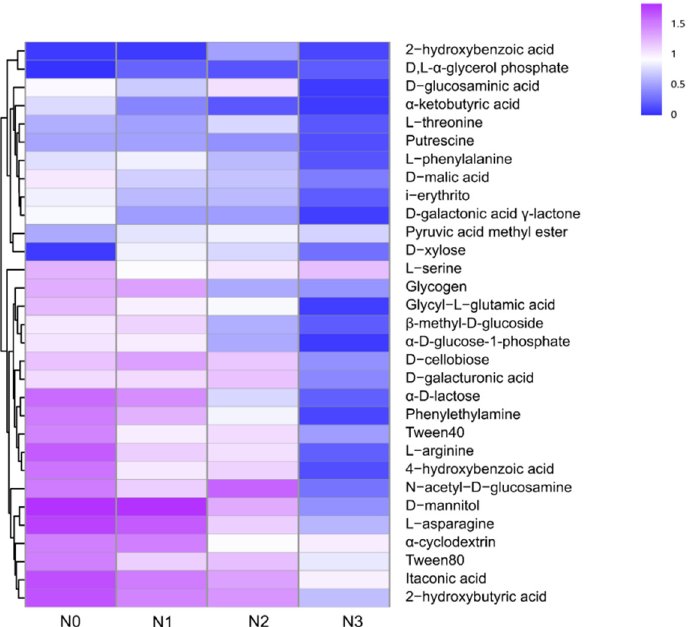
Figure 4. Heat map showing the utilization rates of 31 different Biolog carbon sources in N-amended (N0–N3) soil. The values are the mean for the time of mesocosms’ incubation (168 h).